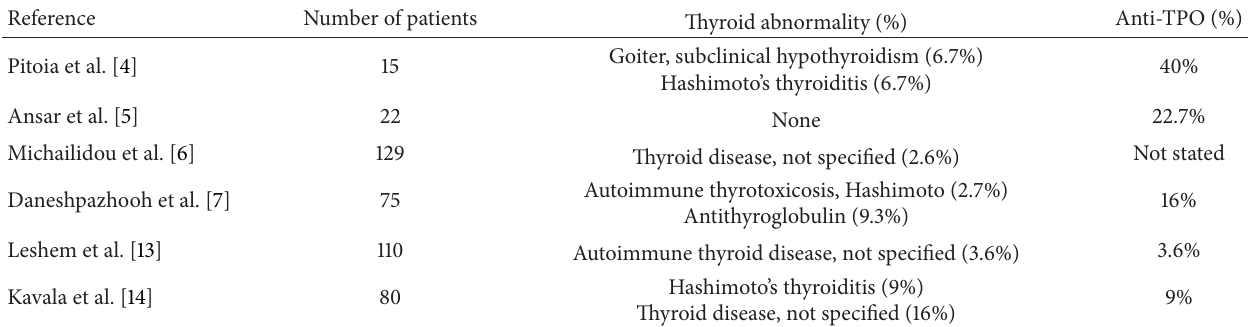
Table 1: The alteration in thyroid function tests and thyroid autoantibodies in patients with pemphigus vulgaris.